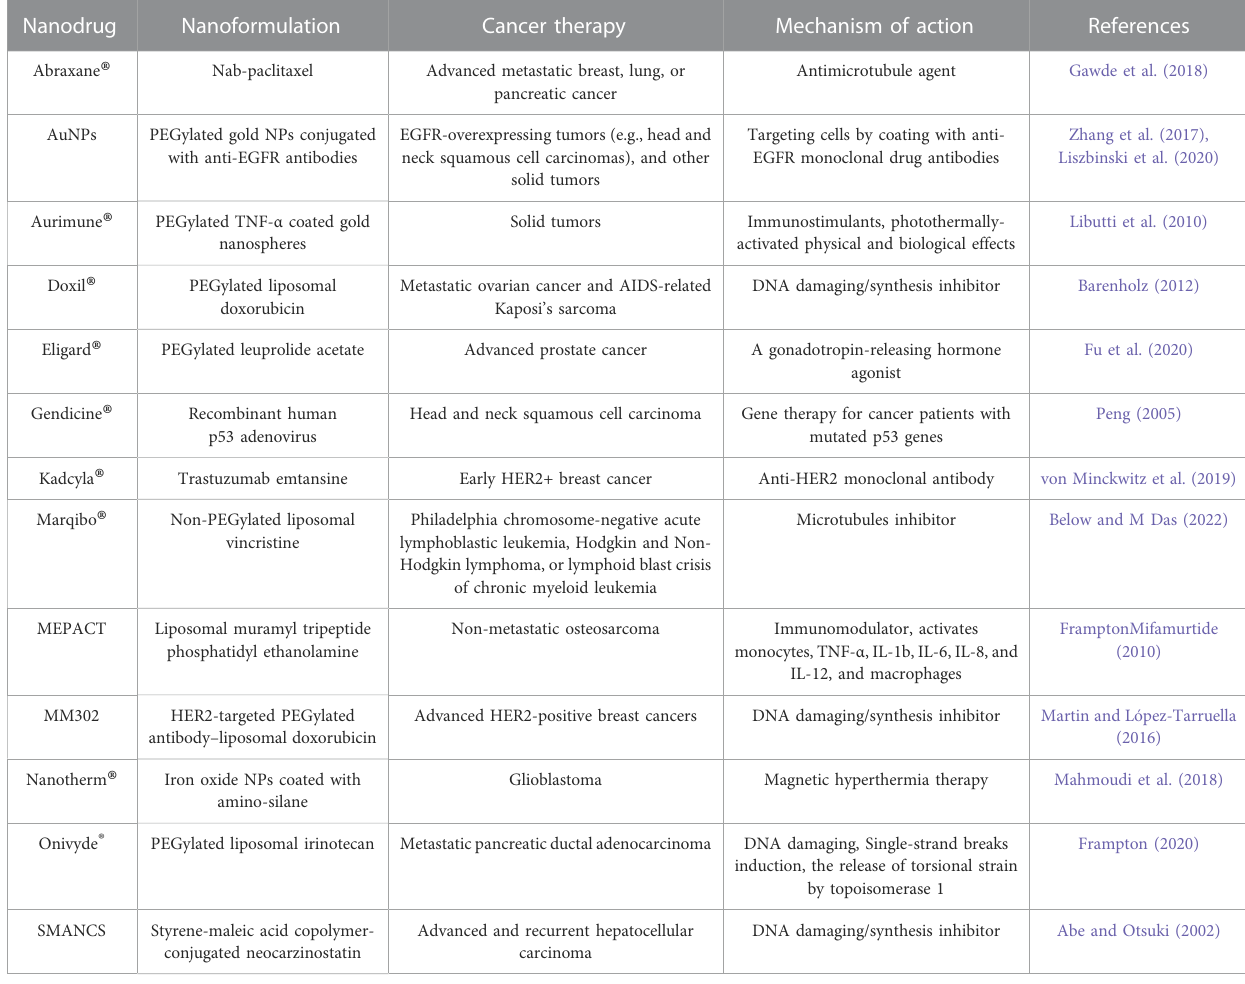
TABLE 1 An overview of FDA-approved nanodrugs used in cancer